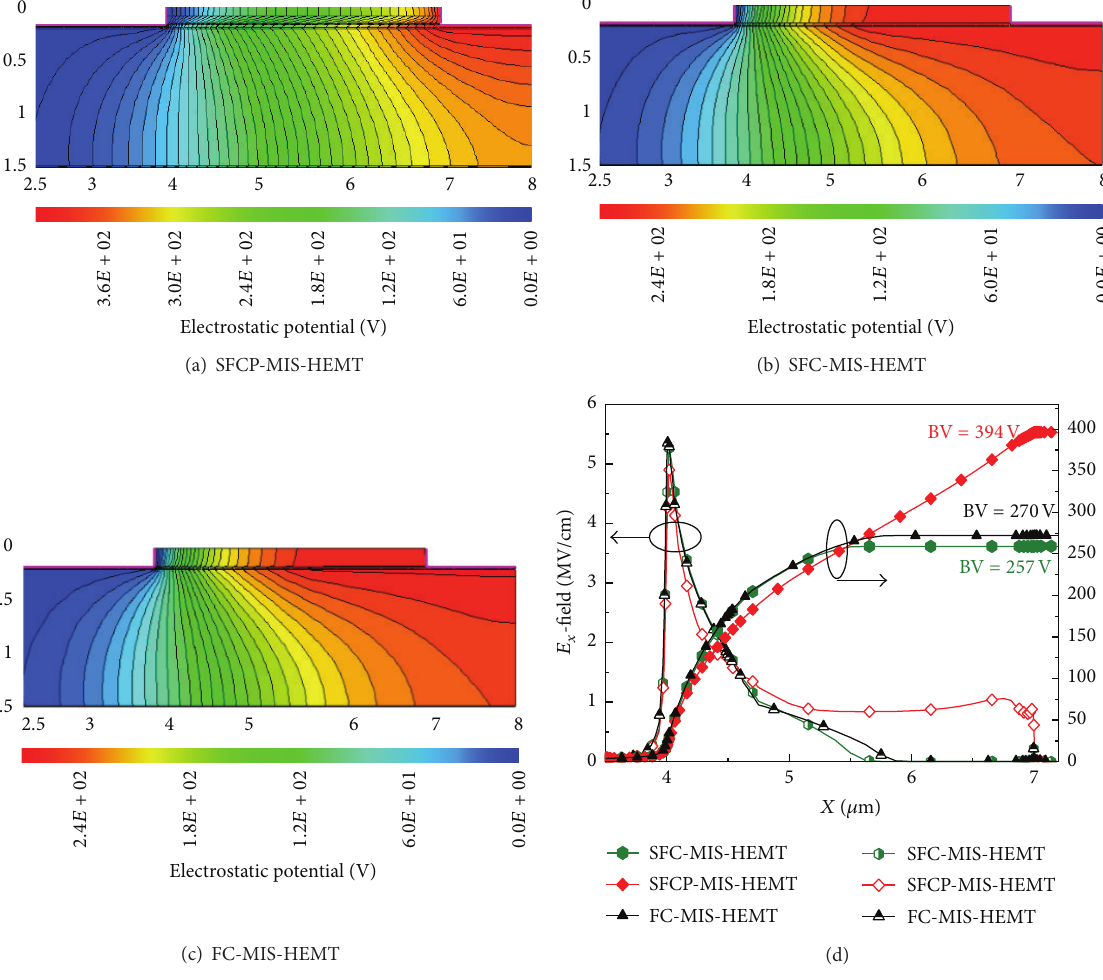
Figure 2: (a)–(c) Equipotential contours distribution at off-state breakdown of three MIS-HEMTs (10V/contour); (d) 𝑋 -component of the surface 𝐸 -field (𝐸 𝑥 ) and the surface potential distributions at AlGaN/GaN